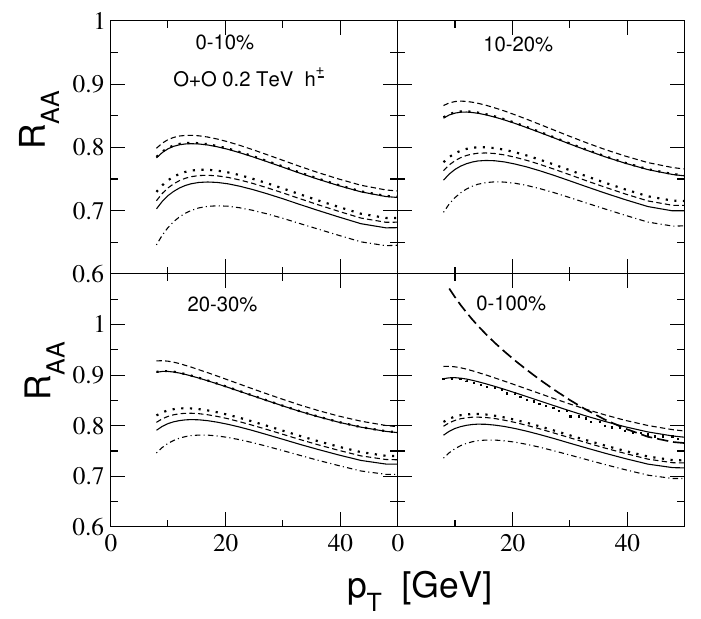
Figure 10 . R AA of charged hadrons for 0 . 2 TeV O+O collisions from our calculations for scenarios (top to bottom) with ( κ = 2 . 55 ) and without ( κ = 3 . 47 ) mQGP formation in pp collisions. The solid and dashed curves are for τ 0 = 0 . 5 , and the dotted ones are for 0 . 8 fm. The solid and dotted curves are obtained for the geometrical parameter k = 2 , and the dashed curves are for k = 3 (see text for explanation). The dash-dotted lines show the results (for k = 2 , τ 0 = 0 . 5 fm, κ = 2 . 55 ) for the intermediate scenario when mQGP formation in pp collisions occurs at the LHC energies, but it is absent at RHIC. The long dashed line shows R pdf AA